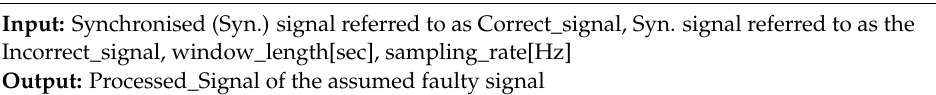
Algorithm 1 For mitigation of the error shown in Figure